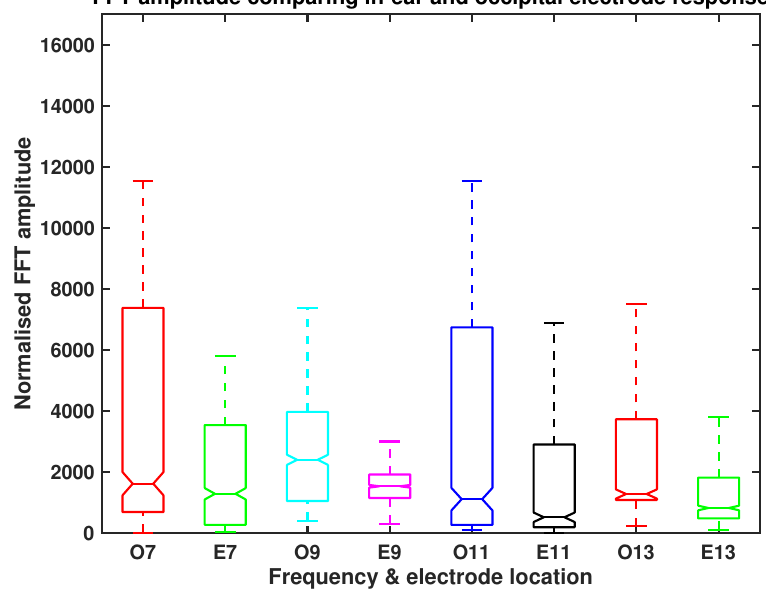
Figure 12. Normalised FFT amplitude for occipital and in-ear location.